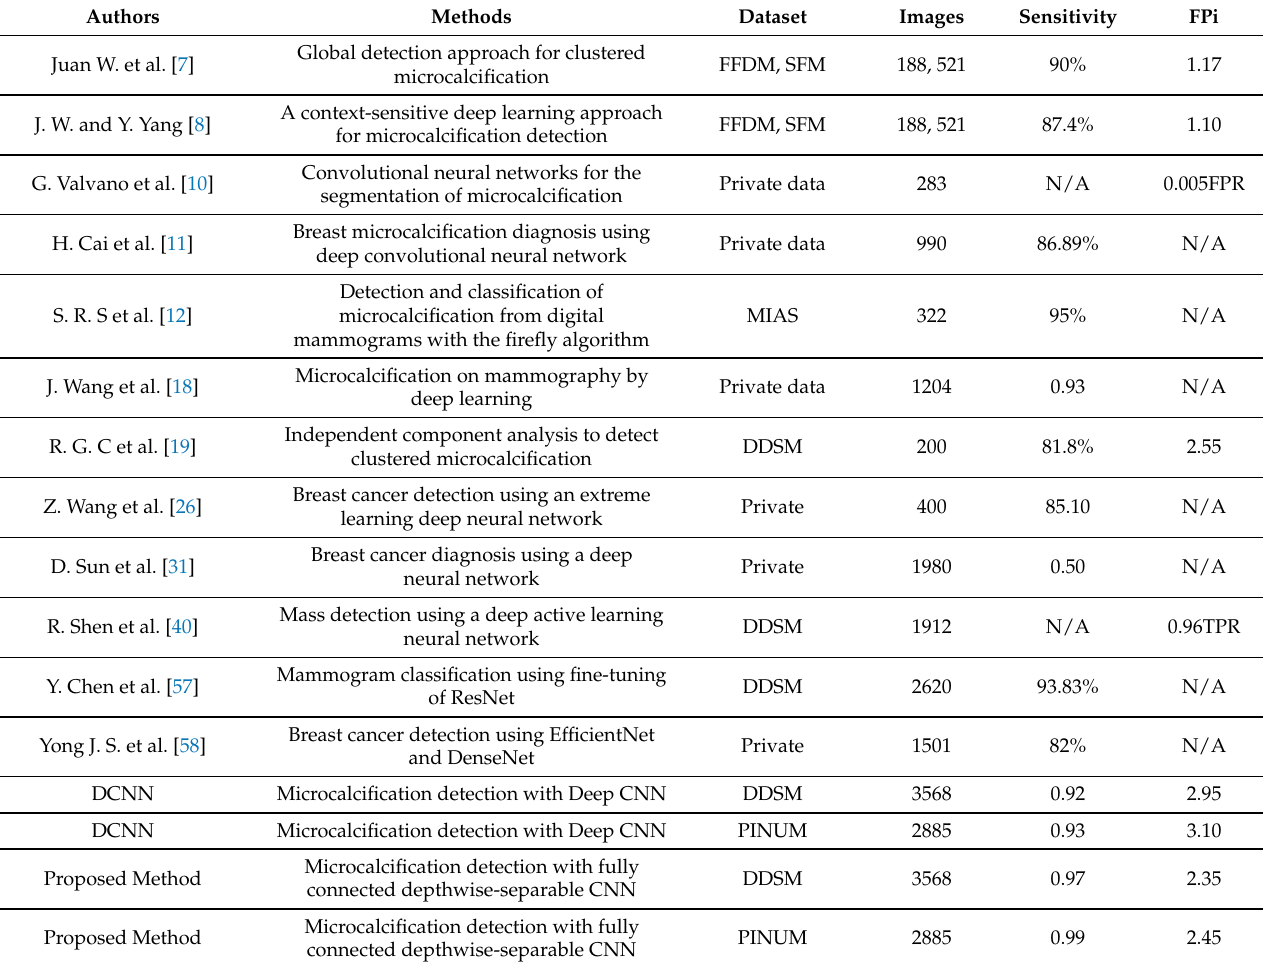
Figure 18. The comparative analysis between the proposed and previous studies showing that the proposed method achieves the maximum sensitivity. Table 5. Comparison of the results with previous studies and the proposed